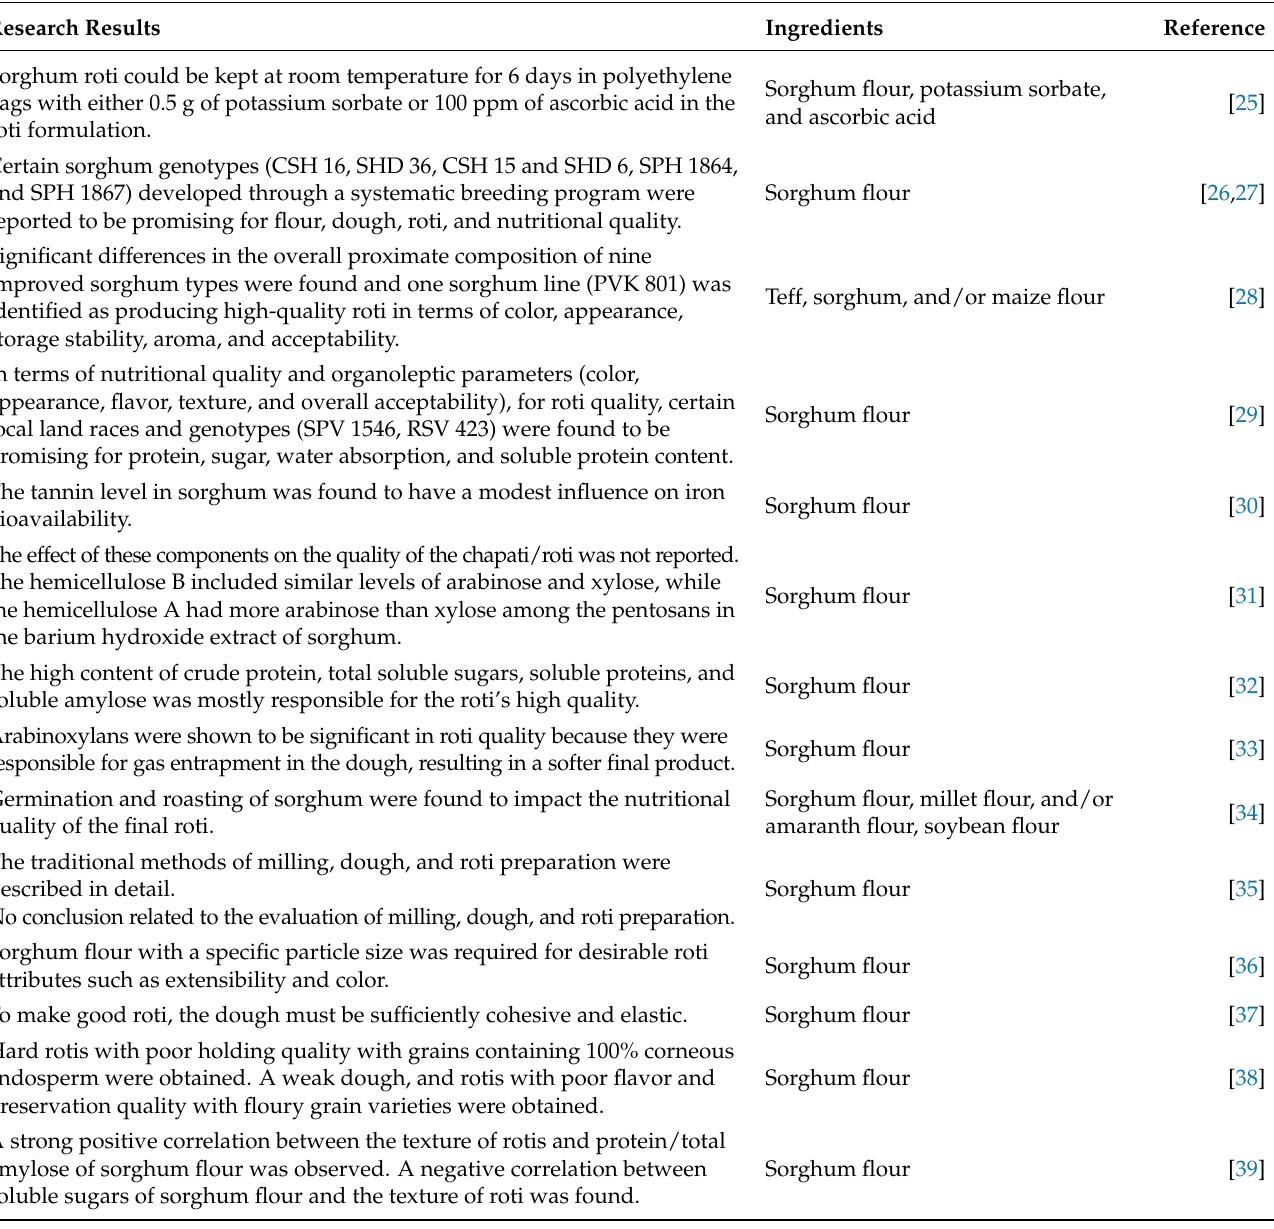
Table 1. The results of studies conducted on sorghum-based